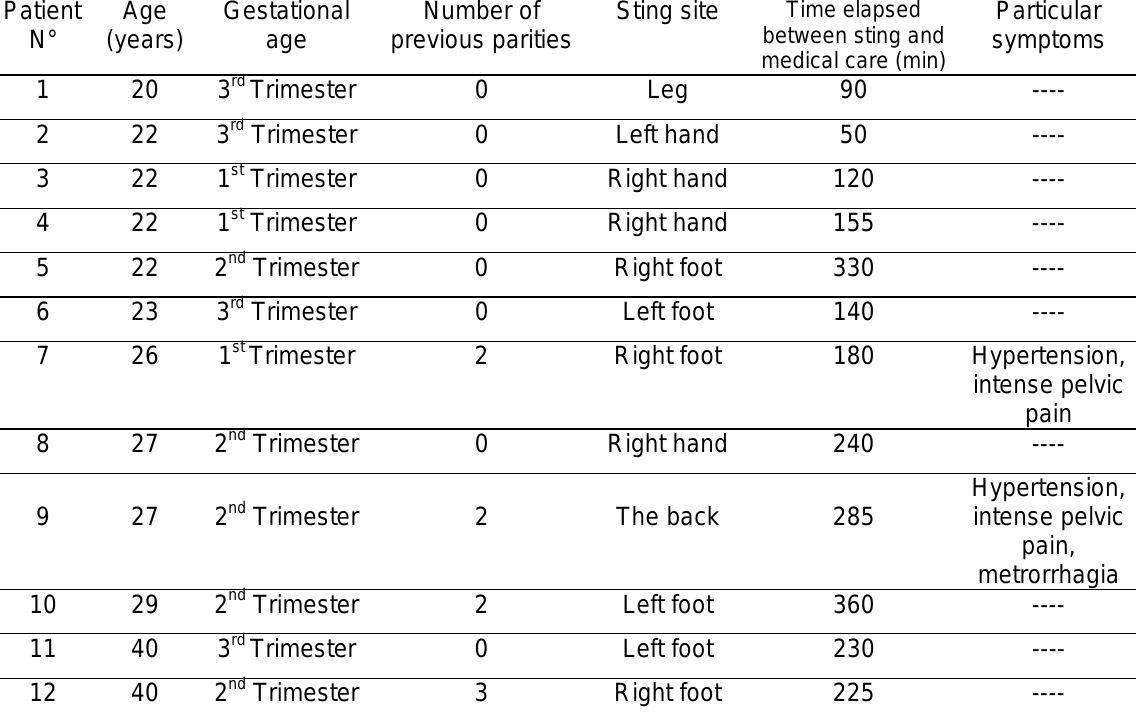
Table 1: Characterization of pregnant patients envenomed by